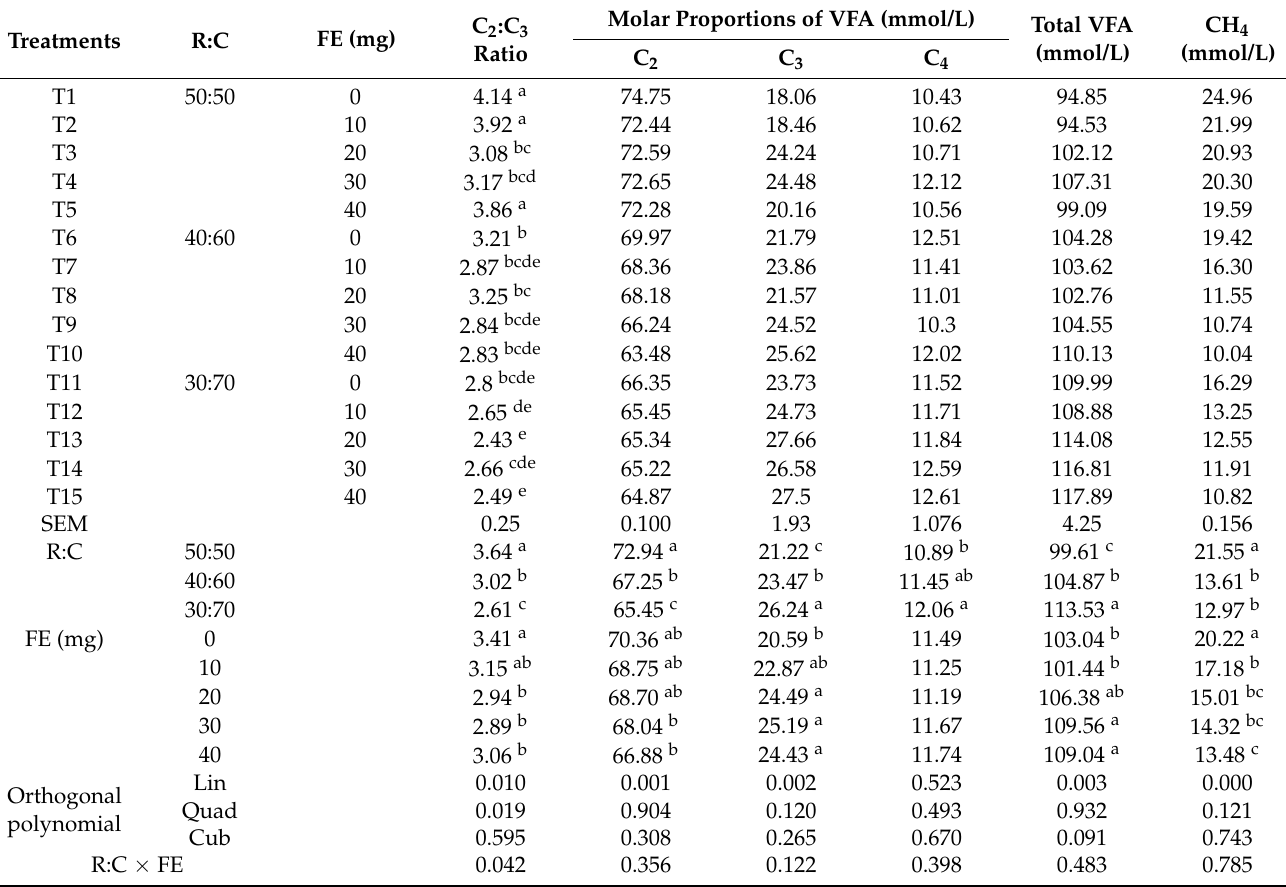
Table 6. Effect of R:C ratios and Brazilian spinach levels on ruminal organic acids and methane (CH 4 ) production.